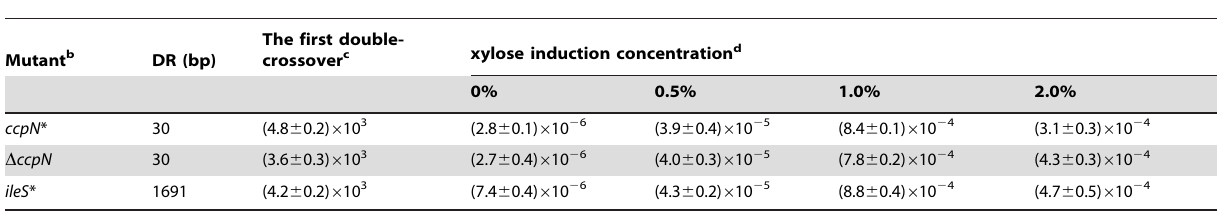
a Data are means 6 SD from three independent experiments for genetic manipulations. b ccpN *, point mutation of ccpN gene (G130T); ileS *, point mutation of ileS gene (G1399A); D ccpN , in-frame deletion of ccpN gene. c The first double-crossover recombination efficiency was calculated as the number of Cm R colonies/ m g of dsDNA PCR product. d Counter-selection efficiency was calculated as Nr/Nt. Nr, number of 5FU R Cm S colonies in the culture treated by different concentration of xylose; Nt, number of total colonies in culture treated by different concentration of xylose.